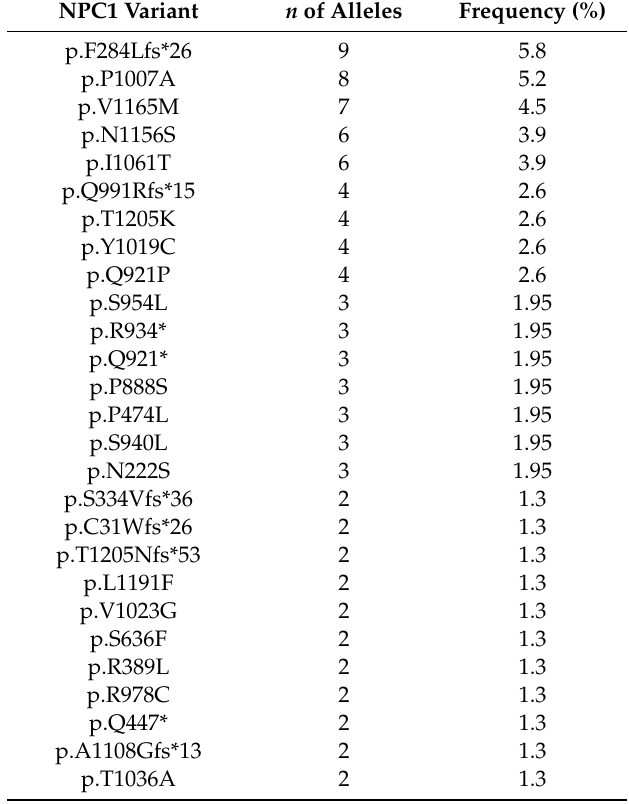
Table 2. Frequency of NPC1 mutant alleles identified in more than one allele.